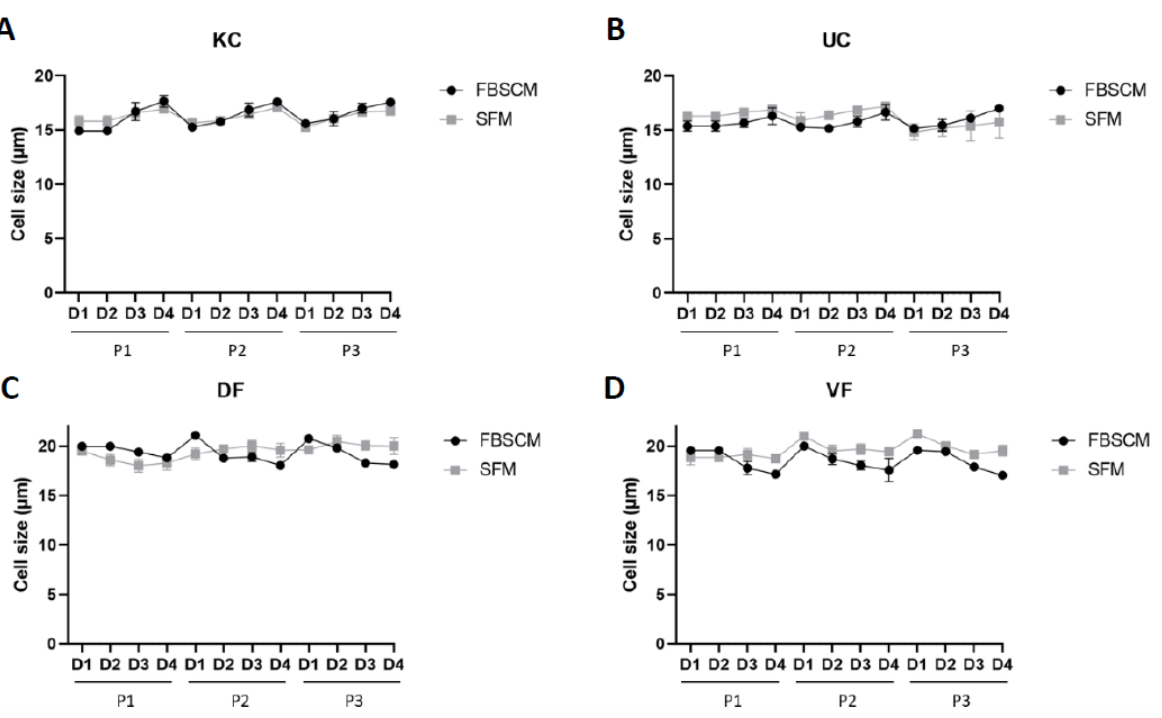
Figure 2. Cell size evaluation of keratinocytes (KC, panel ( A )), urothelial cells (UC, panel ( B )), der- mal fibroblasts (DF, panel ( C )) and vesical fibroblasts (VF, panel ( D )) each day for a period of three passages. Each dot represents the mean of the cell size of three cellular populations, each realized in triplicate (N = 3, n = 3).